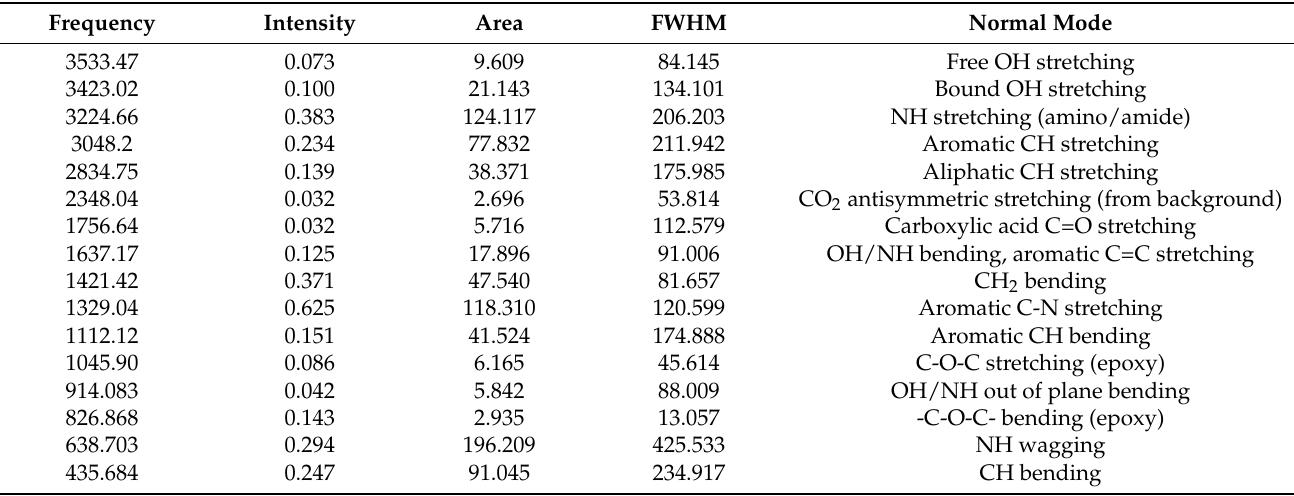
Figure 1. Bare N - CQDs experimental infrared spectrum (green bold line) and its deconvolution (thin lines, various colors). A total of 16 Lorentzian functions was used to fit the total pattern. Table 1. Putative deconvolution of experimental FTIR pattern of bare N - CQDs.